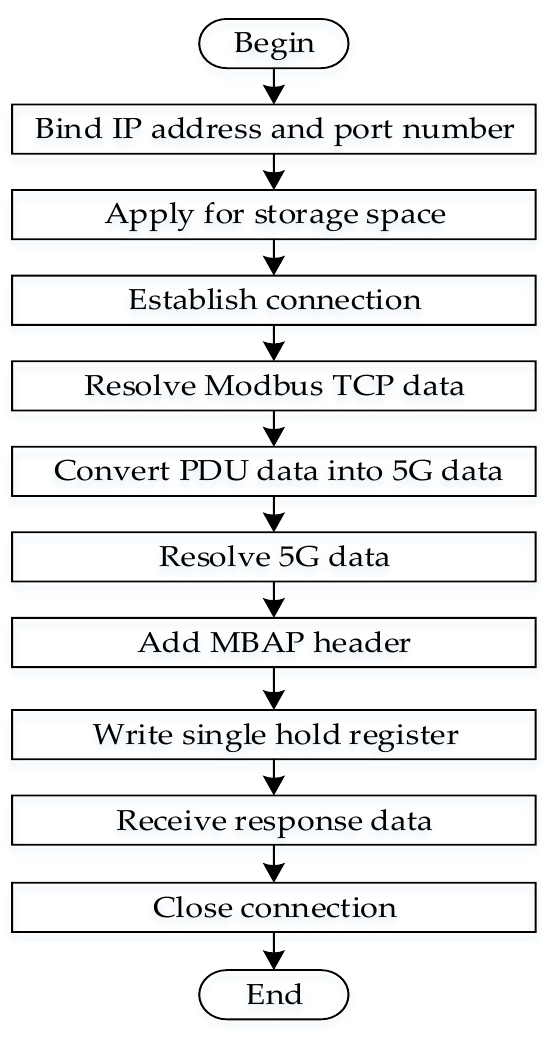
Figure 14. The software implementation process for Modbus TCP.